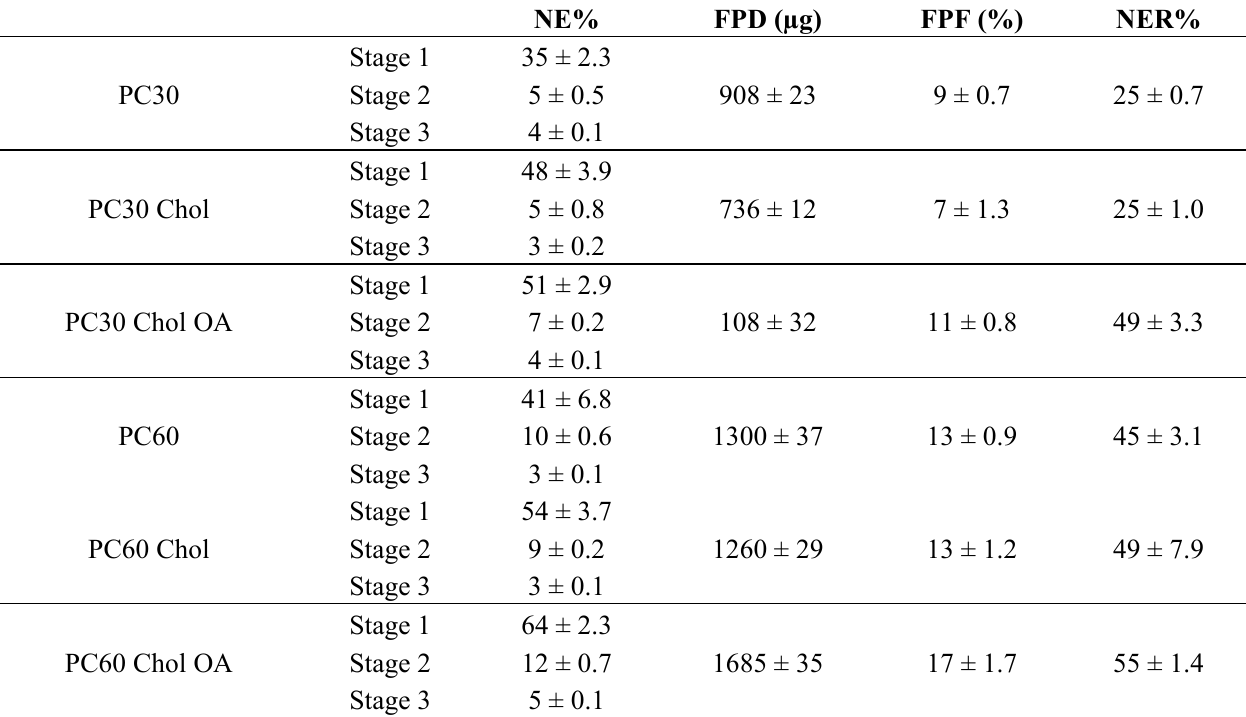
Table 3. Nebulization Efficiency (NE%) and RFP retained into vesicles in the nebulized fraction (NER) of liposomes containing 30 or 60 mg/mL of